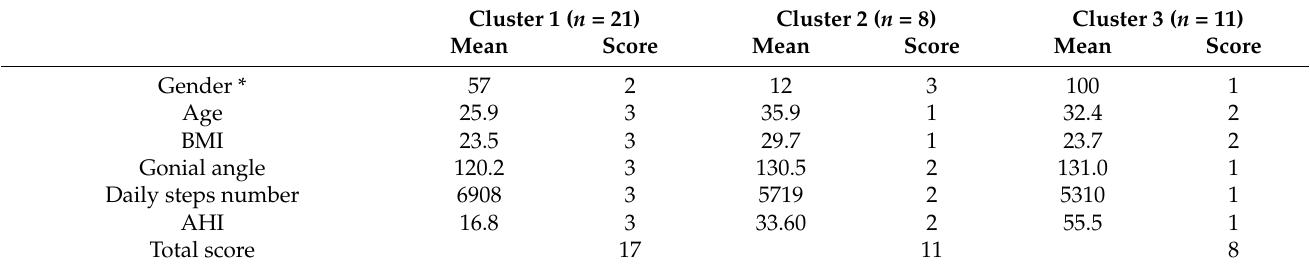
Table 3. Average score in each cluster for all variables used in